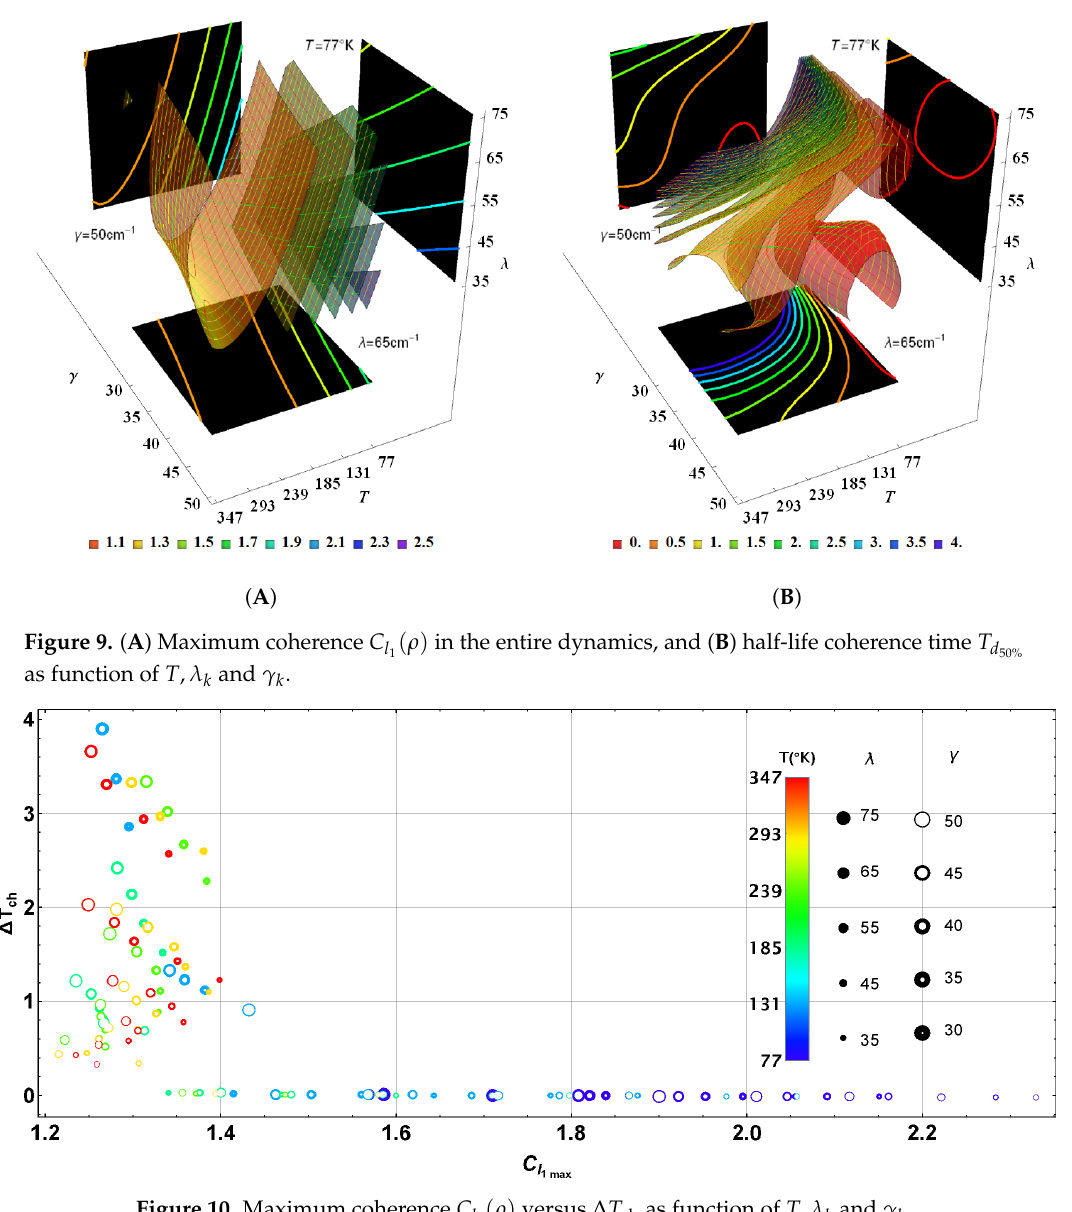
Figure 10. Maximum coherence C l